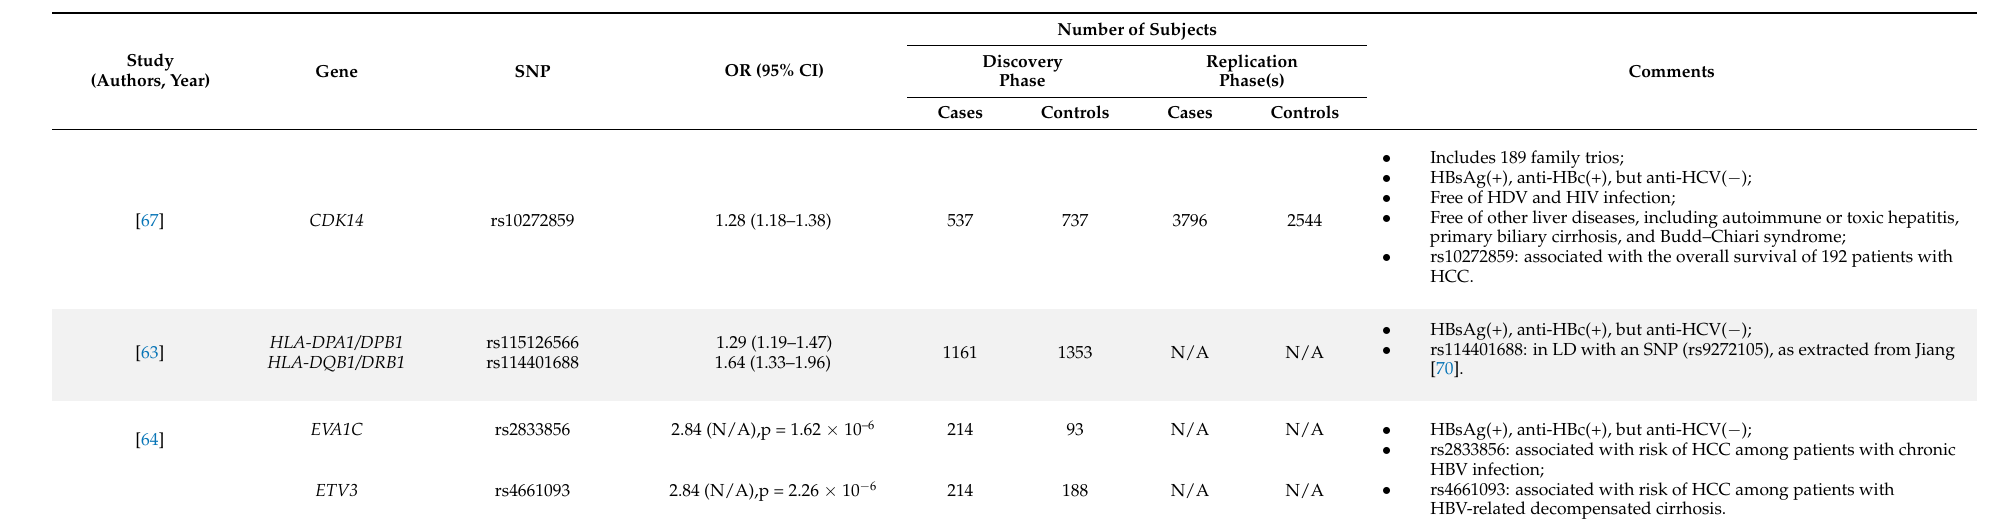
Abbreviations: OR, odds ratio. CI, confidence interval. GWAS, genome-wide association study. HCC, hepatocellular carcinoma. HBV, hepatitis B virus. LD, linkage disequilibrium. N/A, not applicable. SNP, single nucleotide polymorphism. (+), seropositive for. ( − ), seronegative